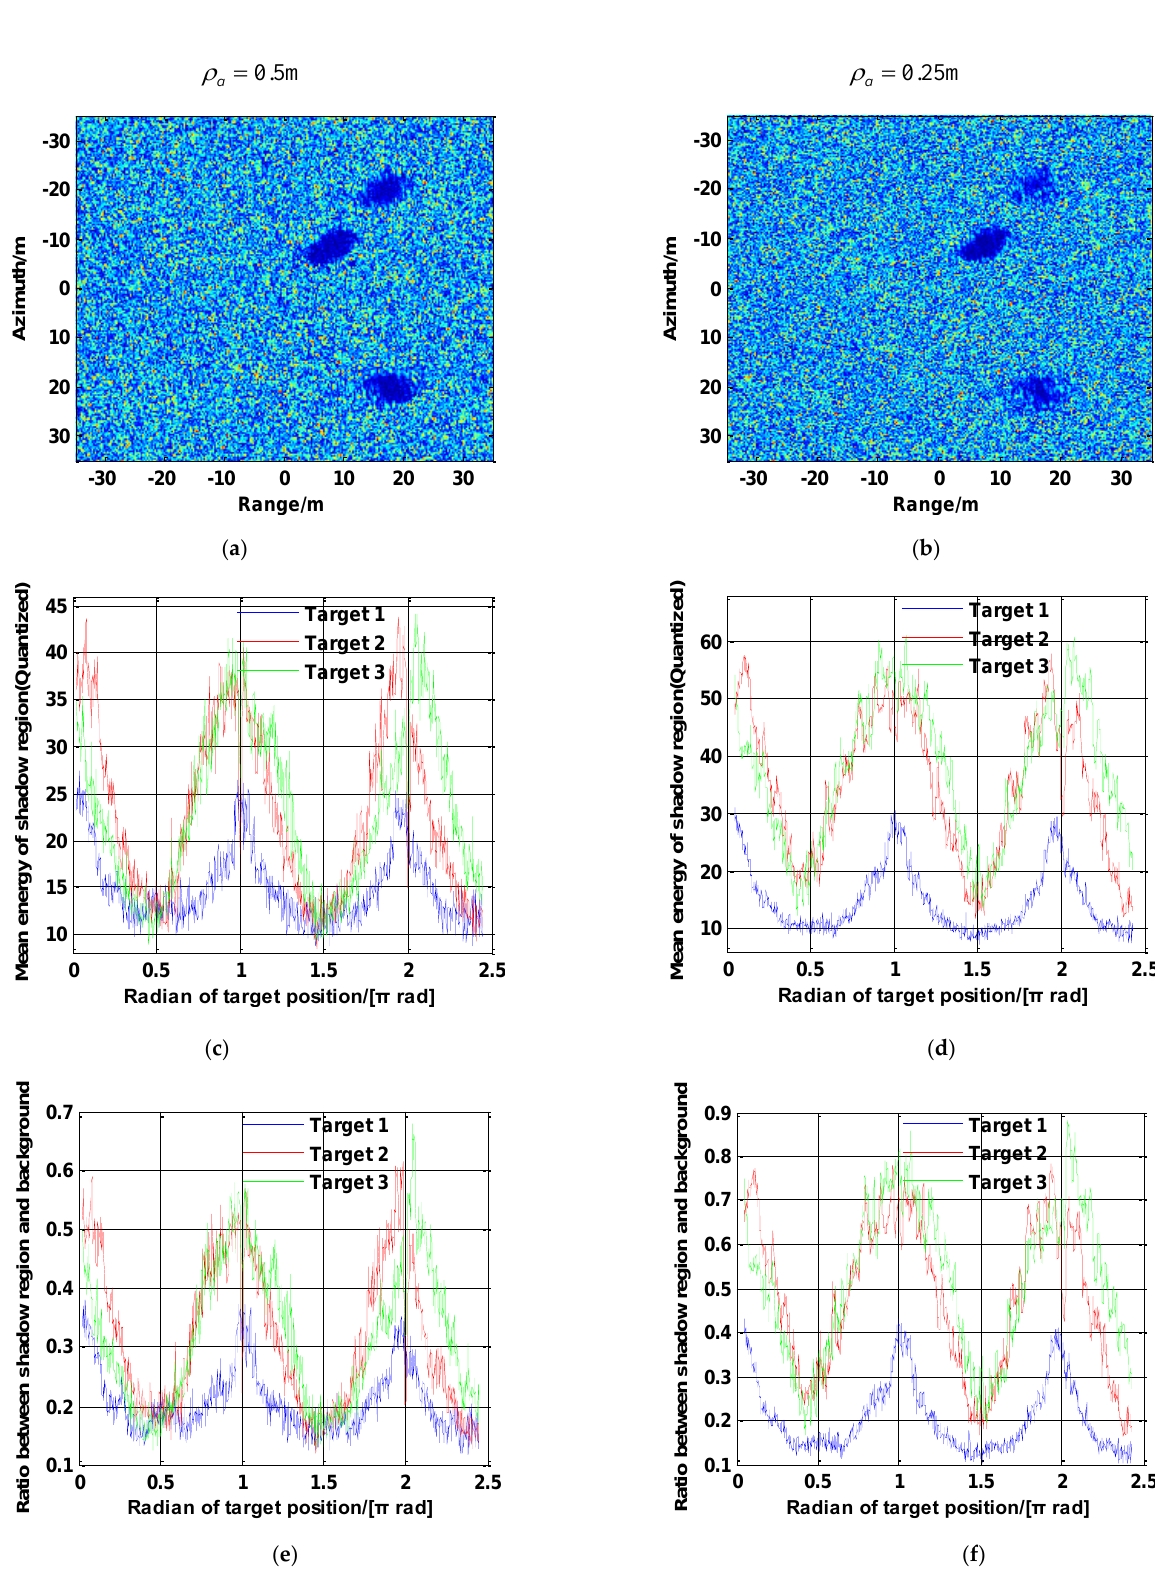
Figure 15. Results of experiment 1. ( a ) Imaging results ( ρ a = 0.5m). ( b ) Imaging results ( ρ a = 0.25m). ( c ) The energy of target shadow at any observing angle ( ρ a = 0.5m). ( d ) The energy of target shadow at any observing angle ( ρ a = 0.25m). ( e ) the energy ratio between target shadow and background ( ρ a = 0.5m). ( f ) the energy ratio between target shadow and background ( ρ a =